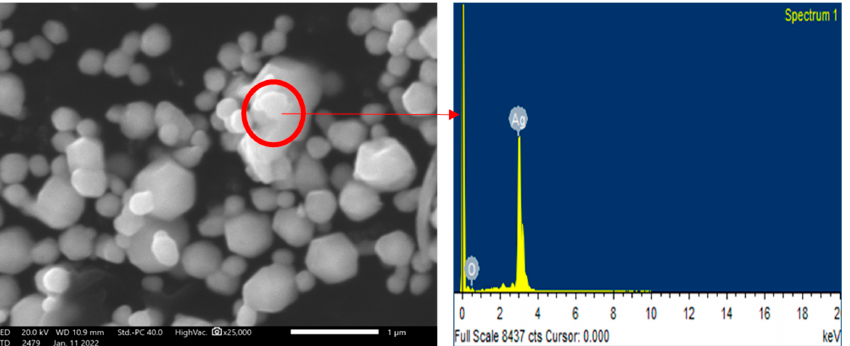
Figure 4. Scanning Electron Micrograph (SEM) of chemically synthesized silver nanoparticles show- ing hexagonal-shaped nanoparticles, and its EDX spectra showing the Ag element.